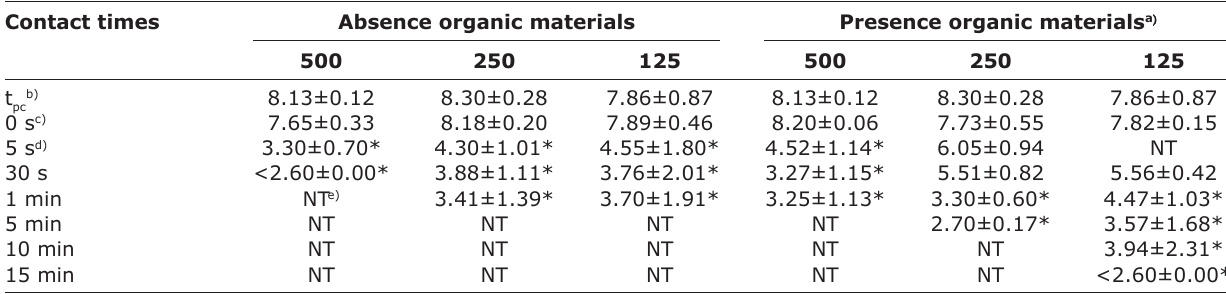
Table-1: The bactericidal efficacy of DDAB against SI in the absence or presence of organic materials. Contact times